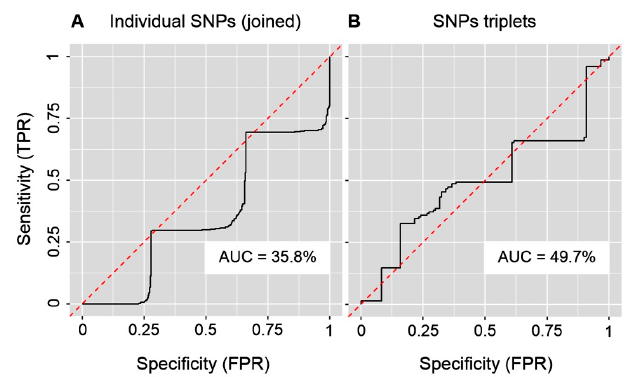
Figure 4. ROC (receiver operating characteristic) curves with the area under the ROC curve (AUC) for the machine-learning Random Forest algorithm with ( A ) the three individual A1 SNPs (summarized in Table 1) as joined predictors and ( B ) with the 27 triplets of the three A1 SNPs (summarized in Table 4) as predictors. Abbreviations: (TPR) true positive rate, (FPR) false positive rate.